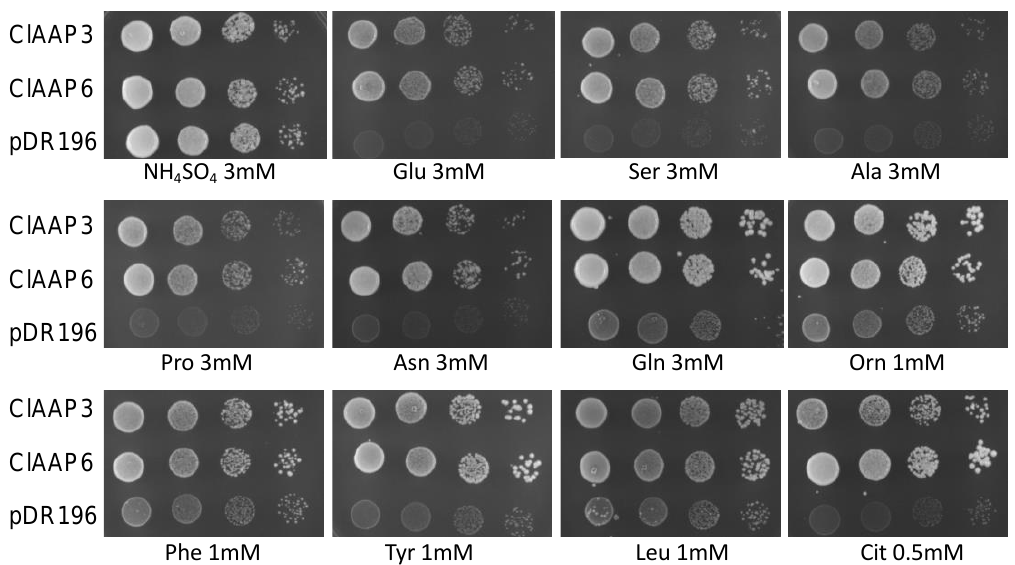
Figure 2. ClAAP3 (Cla023187) and ClAAP6 (Cla023090) complements the growth of 22 ∆ 10 α on amino acids. 22 ∆ 10 α cells carrying either ClAAP3 , ClAAP6, or the empty vector (pDR196) were grown for 3–4 days on a minimal medium containing either NH 4 SO 4 or amino acids as the sole nitrogen source at the concentrations indicated. Cells were diluted tenfold from left to right, with the left column representing OD 600 = 1.0.